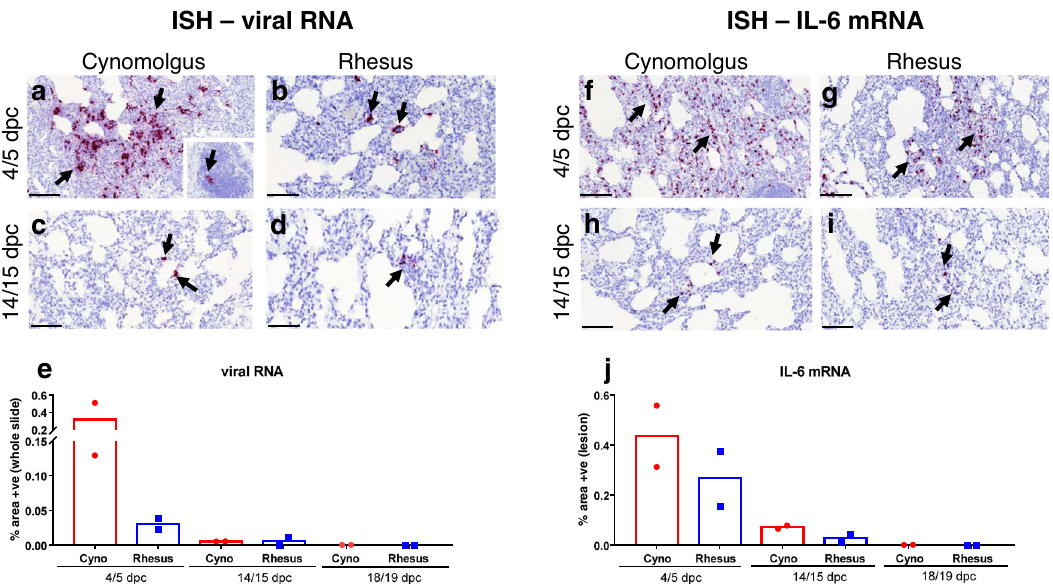
Fig. 6 Presence of viral RNA and IL-6 by ISH in cynomolgus and rhesus macaques during SARS-CoV-2 infection. ISH detection of abundant viral RNA (RNAScope, red chromogen) within the areas of pneumonia ( a , arrows) and occasionally in the BALT ( a , insert, arrow) in cynomolgus ( a , b ) and rhesus macaques ( b , arrows) at 4/5 dpc. Small amount of viral RNA in the interalveolar septa from cynomolgus ( c , arrows) and rhesus macaques ( d , arrows) at 14/15 dpc. Image analysis of positively stained area in RNASCope labelled sections for viral RNA ( e , whole slide); n = 2 macaques per species and time point; bars represent median values. Abundant presence of IL-6 mRNA in the areas of pneumonia from cynomolgus ( f , arrows) and rhesus macaques ( g , arrows) at 4/5 dpc. Small amount of IL-6 mRNA positive cells within the interalveolar septa from cynomolgus ( h , arrows) and rhesus macaques ( i , arrows) at 14/15 dpc. Image analysis of positively stained area in RNASCope labelled sections for IL-6 mRNA ( j , areas of lesion); n = 2 macaques per species and time point; bars represent median values. Bars in micrographs = 200 µ m.